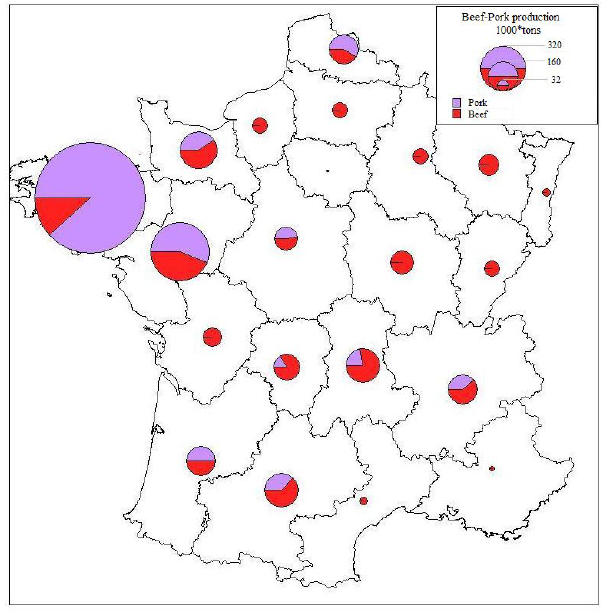
Fig. 1. Beef (red) and pork (purple) production per French admin- istrative region. Data sources: Statistique agricole annuelle, 2006.